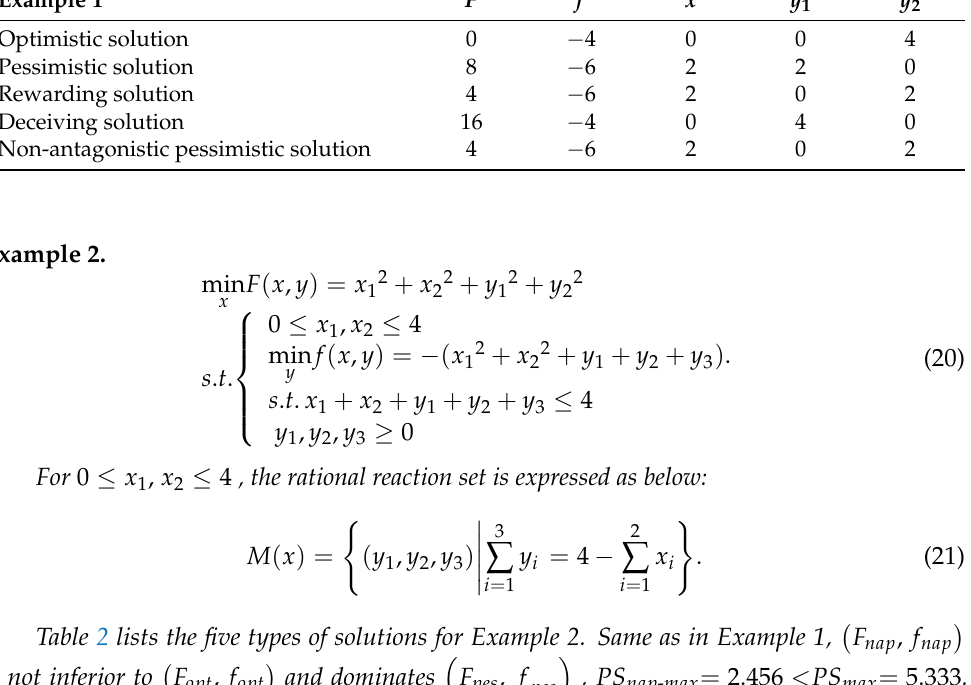
Table 2 lists the five types of solutions for Example 2. Same as in Example 1,